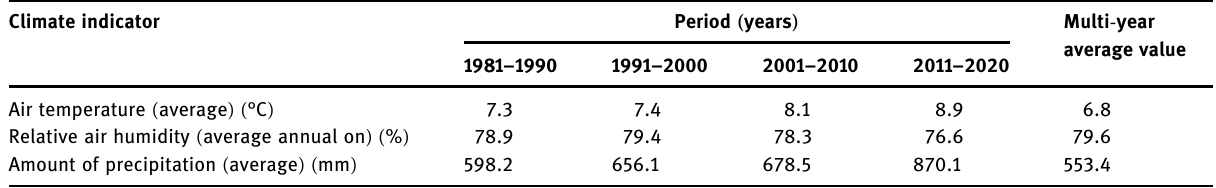
Table 1: Long - term dynamics of the main climatic indicators in the western forest steppe of Ukraine Climate indicator